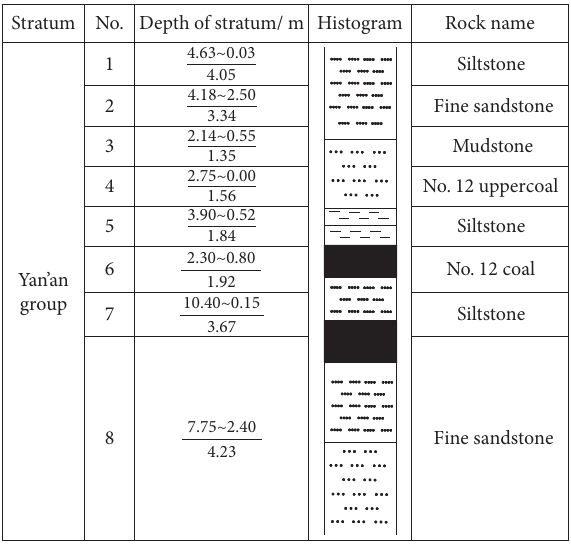
Figure 2: Comprehensive histogram of the 12201 fully mechanized mining